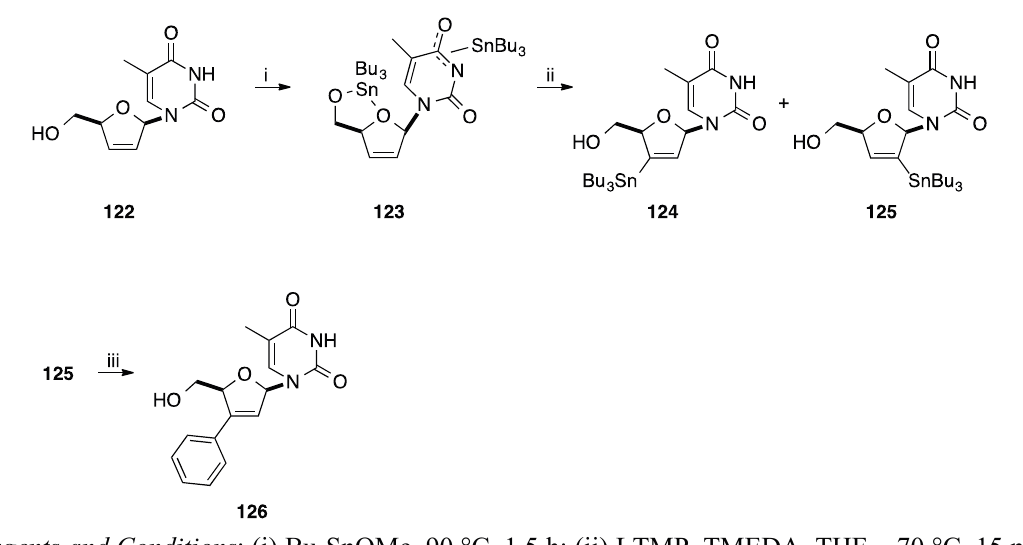
Scheme 15. Synthesis of 3'- C -phenyl d4T 126